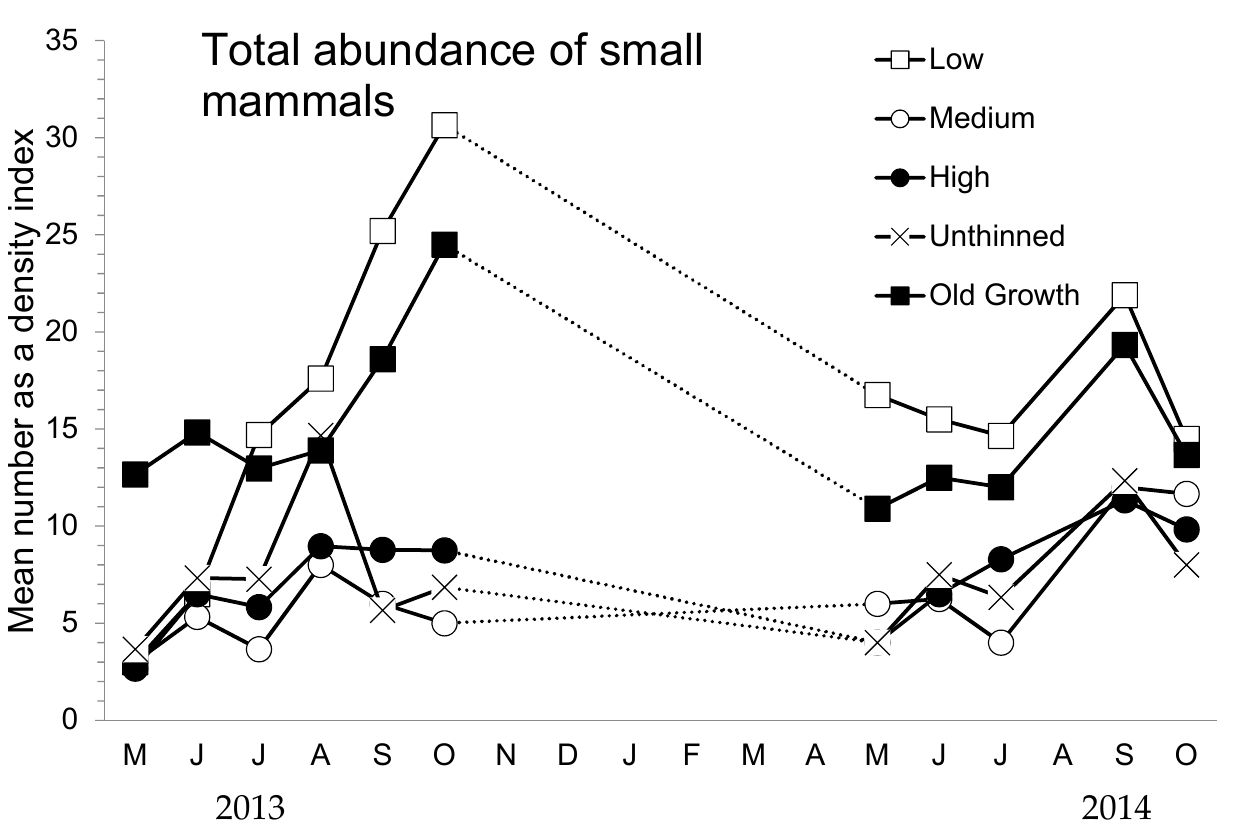
Figure 2. Mean ( n = 3 replicate sites) total abundance of forest-floor small mammals as an index based on Jolly-Seber population estimates 2013 to 2014 in three thinned, unthinned, and old-growth stands in south-central British Columbia, Canada. Datapoints indicate individual trapping weeks each summer (May to October) and dots indicate the winter period when we did not sample populations.